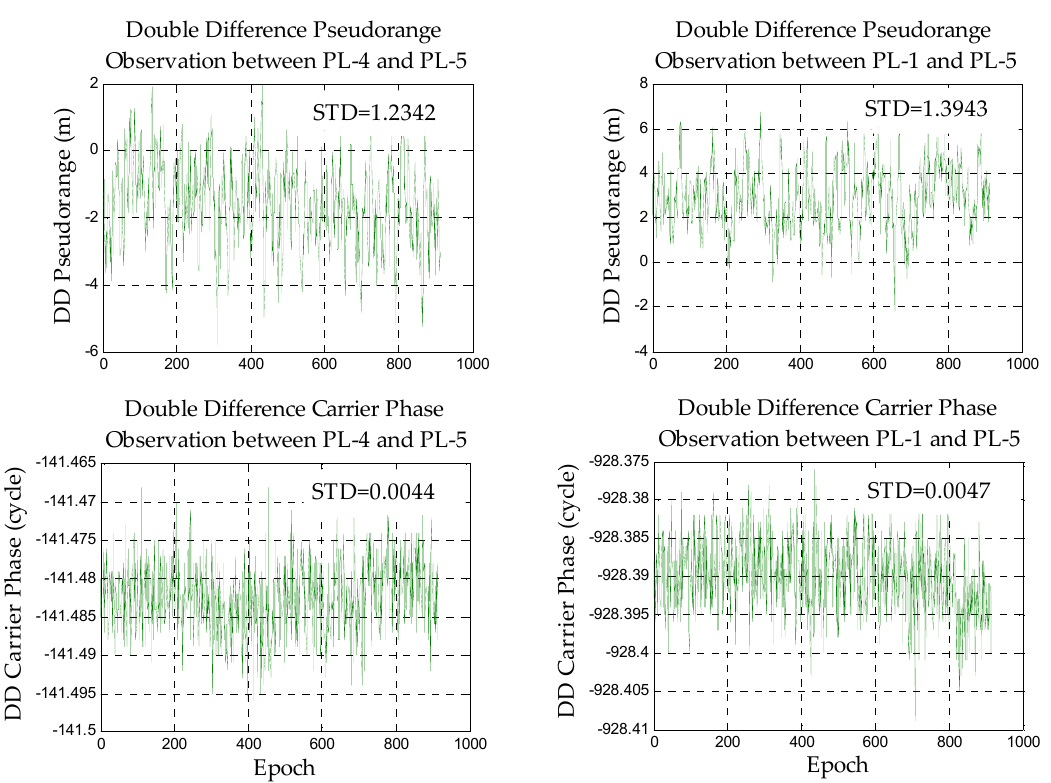
Figure 5. The double difference observations in the short baseline.